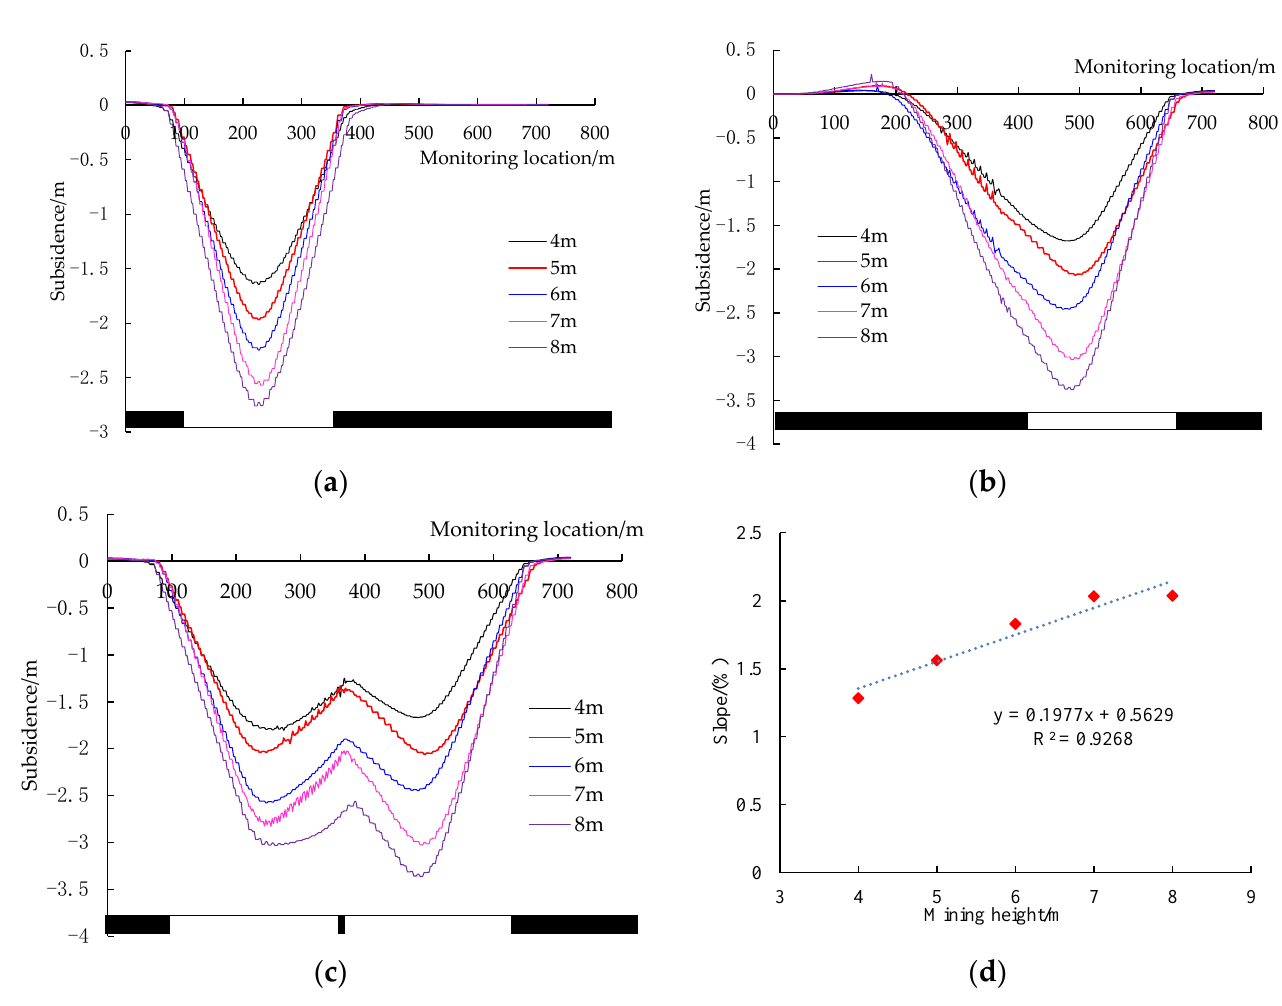
Figure 17. Surface subsidence due to mining with different height: ( a ) first working face; ( b ) second working face; ( c ) two working faces; ( d ) slope of the surface subsidence trough.